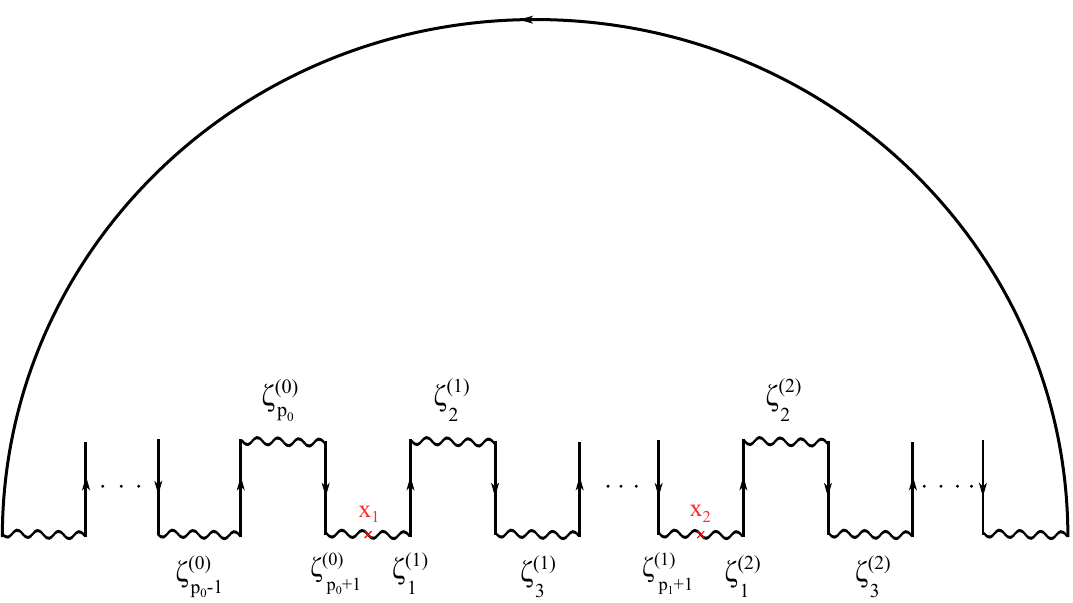
Figure 6 . This (cid:12)gure gives a the bow describing the Coulomb branch of 3D N = 4 theory with gauge group G = Q U( m s ) and p I = P p ( n ) s n